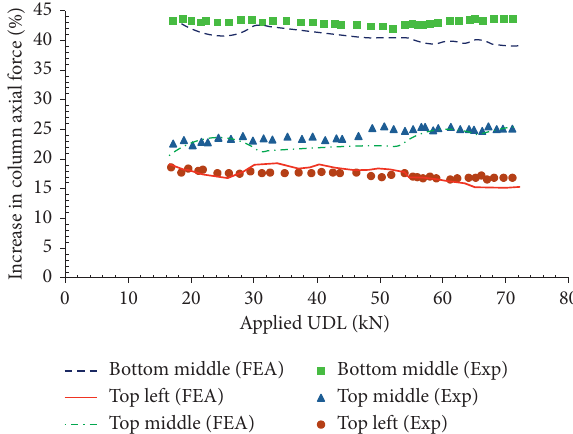
Figure 5: Increase in axial force of the supports adjacent to the removed column location during overloading